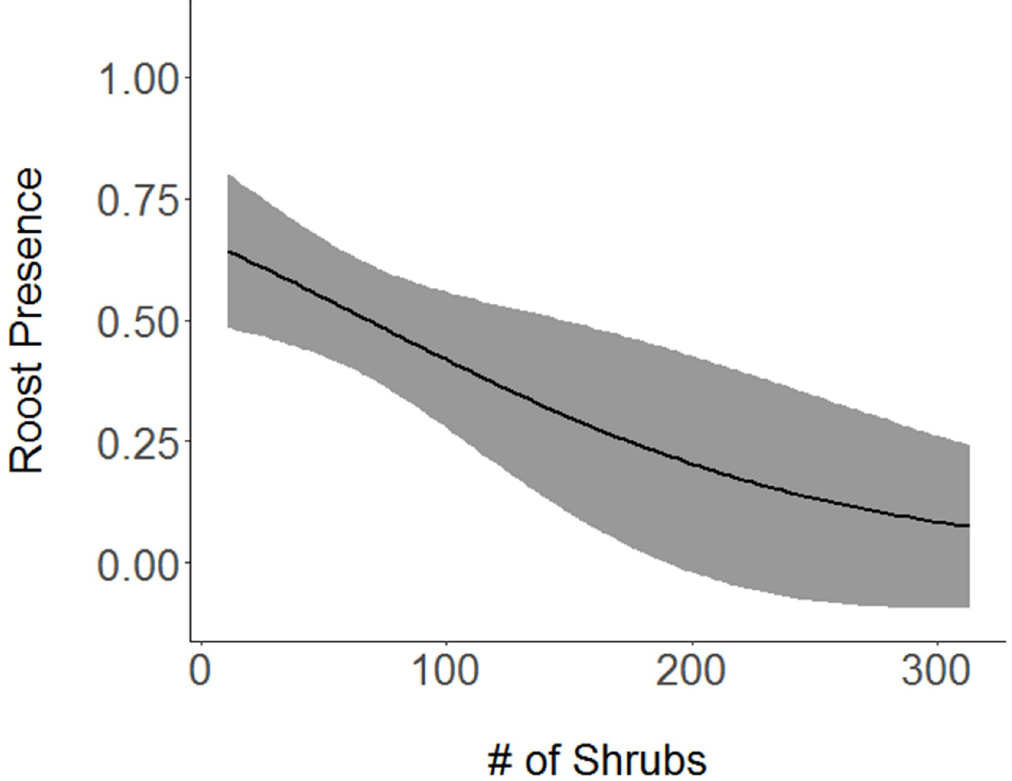
Fig 2. Association between Cerulean Warbler roosts and shrubs. Cerulean Warbler ( Setophaga cerulea , Wilson) roost sites were negatively associated with an increased number of shrubs in Morgan-Monroe and Yellowwood state forests, southern Indiana, 2017. The gray area represents 95% confidence intervals. Original data are shown on the x-axis.